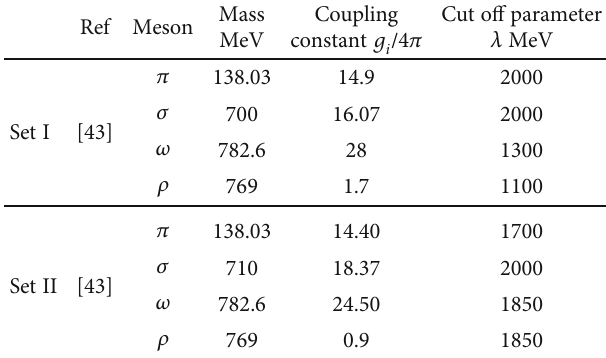
Table 1: The meson parameters for OBEP for di ff erent sets [43].